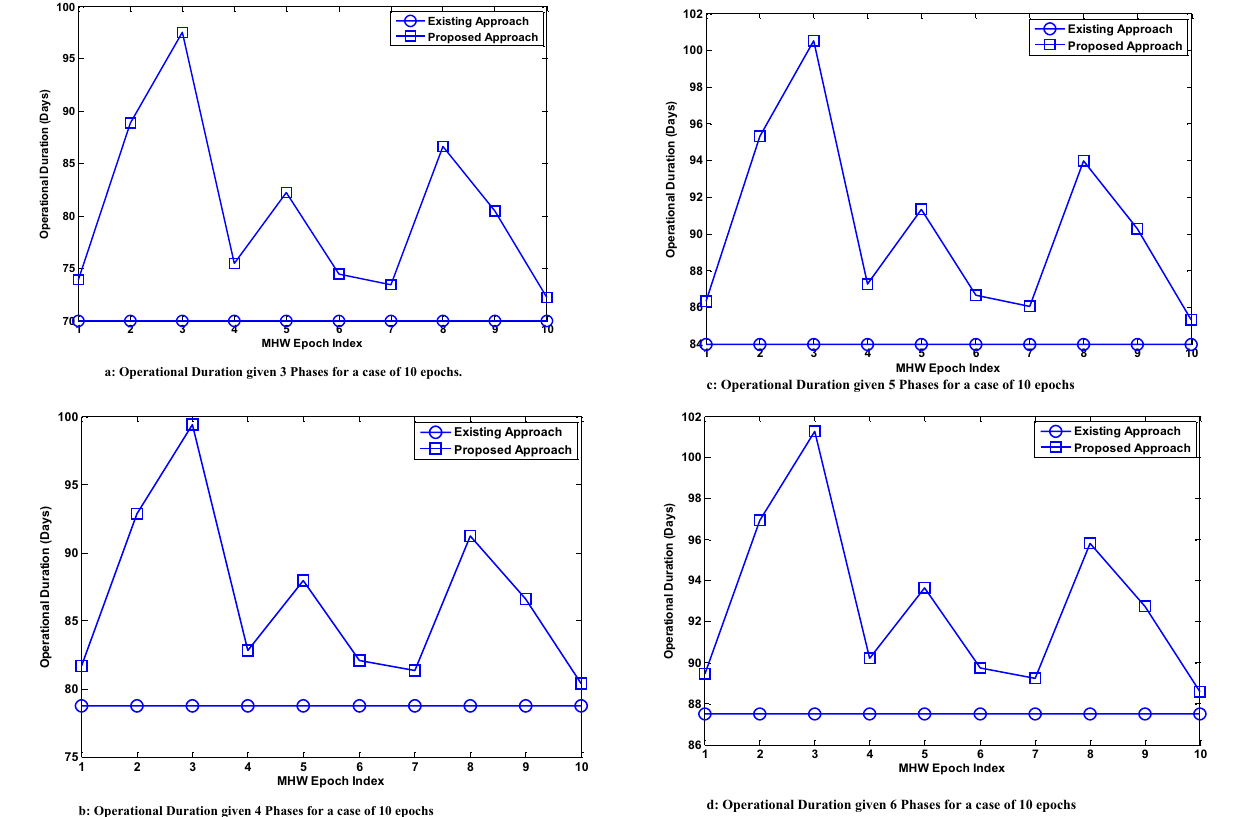
Figure 9. ( a ) Operational Duration given 3 Phases for a case of 10 epochs. ( b ) Operational Duration given 4 Phases for a case of 10 epochs. ( c ) Operational Duration given 5 Phases for a case of 10 epochs. ( d ) Operational Duration given 6 Phases for a case of 10 epochs. Evaluation showing results for the underwater data center duration (for 3 phases, 4 phases, 5 phases and 6 phases) in the case that the marine heat wave event occurs for 10